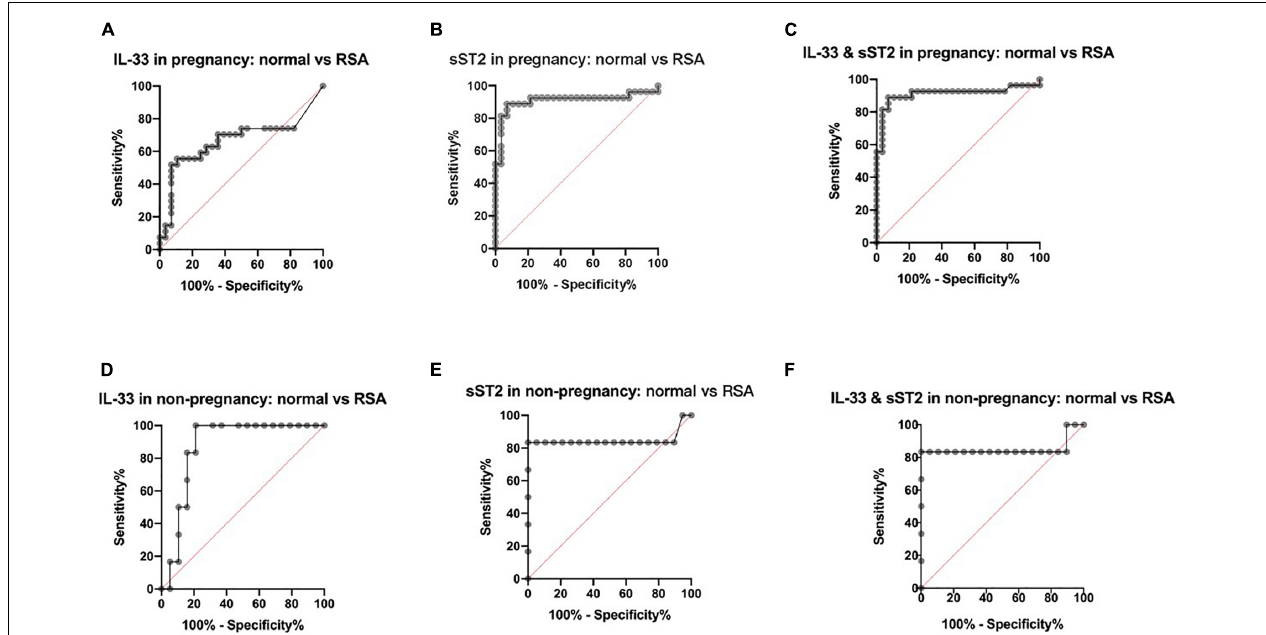
FIGURE 2 | Predictive value of maternal serum IL-33 and ST2 level in RSA. (A) ROC curve analysis of serum IL-33 level in the pregnancy groups, AUC=0.6660. (B) ROC curve analysis of serum solubleST2 level in the pregnancy groups, AUC=0.9087. (C) ROC curve analysis of serum IL-33 and sST2 levels in the pregnancy groups, AUC = 0.9107. (D) ROC curve analysis of serum IL-33 level in the non-pregnancy groups, AUC=0.8684. (E) ROC curve analysis of serum solubleST2 level in the non- pregnancy groups, AUC=0.8465. (F) ROC curve analysis of serum IL-33 and sST2 levels in the non-pregnancy groups, AUC=0.8509.